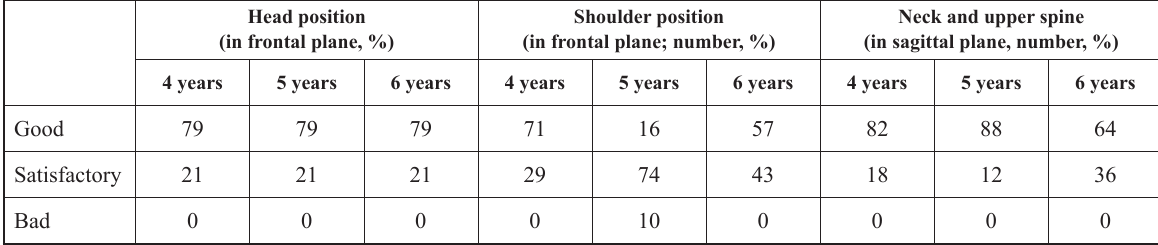
Table 3. Analysis of spine, pelvis, knee and ankle in the age group 4–6-year-old children